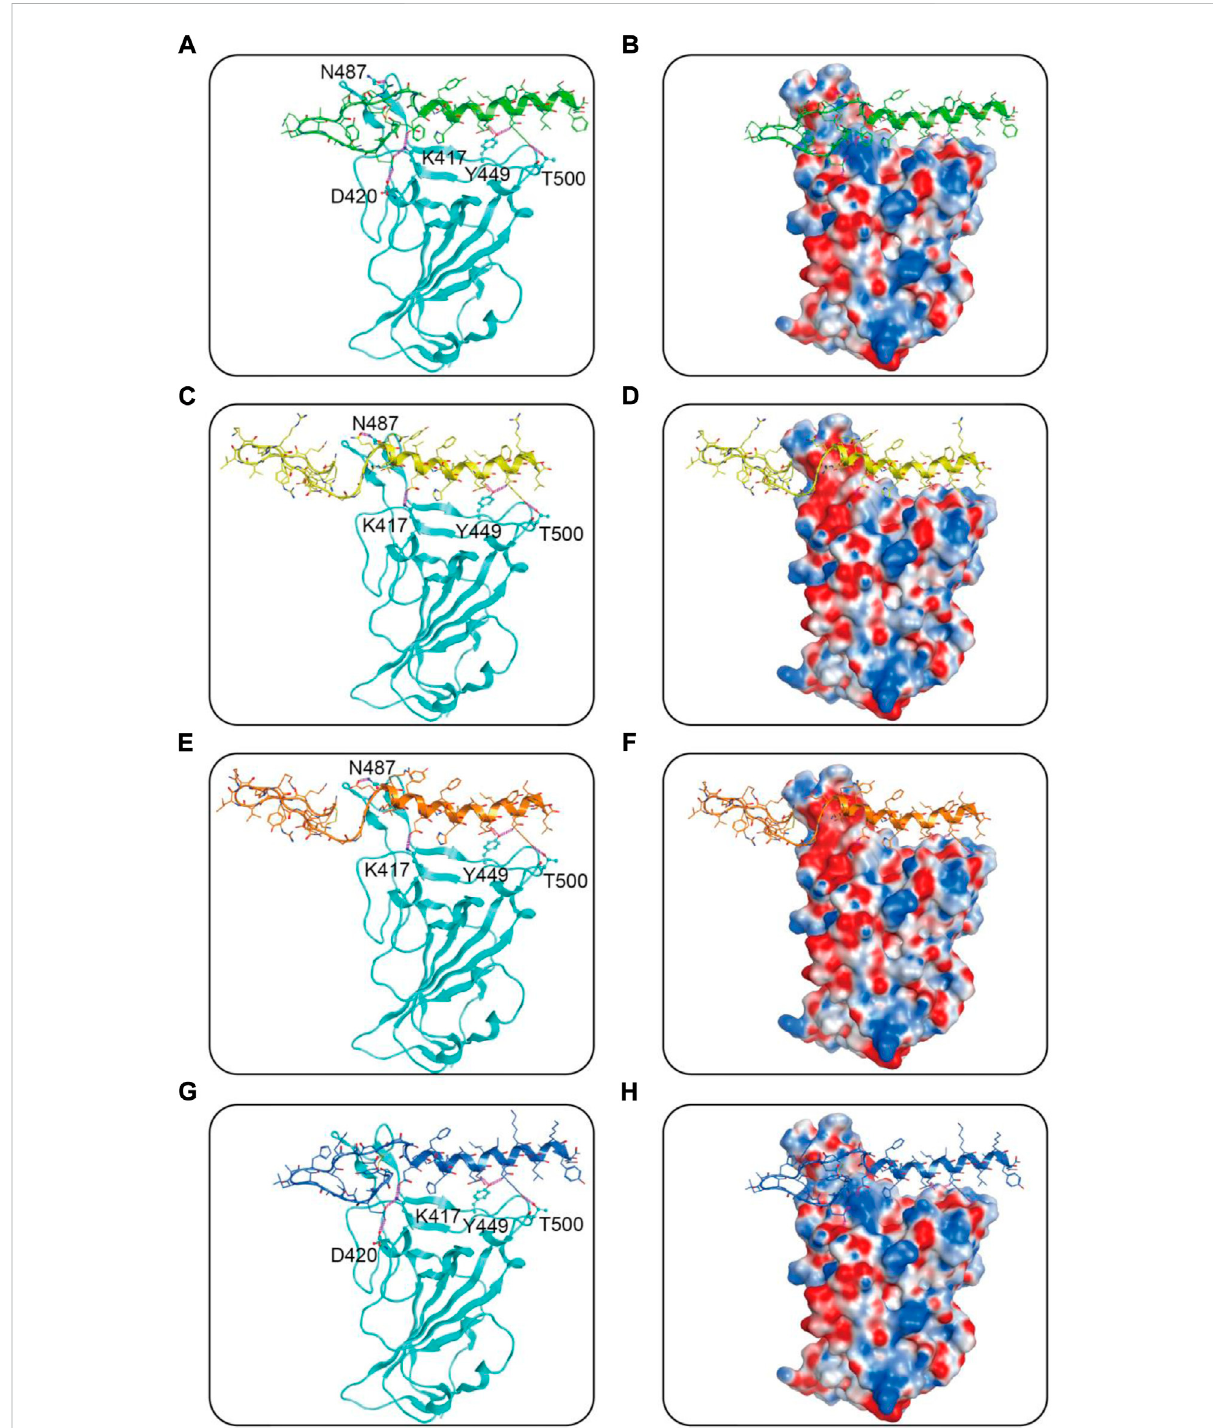
FIGURE 4 PredictedbindingmodesofMRs1-4intheactivesiteofRBD: (A , B) MR-1; (C , D) MR-2; (E , F) MR-3; (G , H) MR-4.TheMRs1-4wererepresentedas sticks with the atoms colored as nitrogen-blue, oxygen-red, sulfur-yellow and carbon-green, yellow, orange, and dark blue, respectively. Residues close to the MRs 1-4 were depicted as sticks with the atoms colored as carbon-azure, nitrogen-blue, and oxygen-red. The hydrogen-bond interactions with protein residues were represented by purple dotted